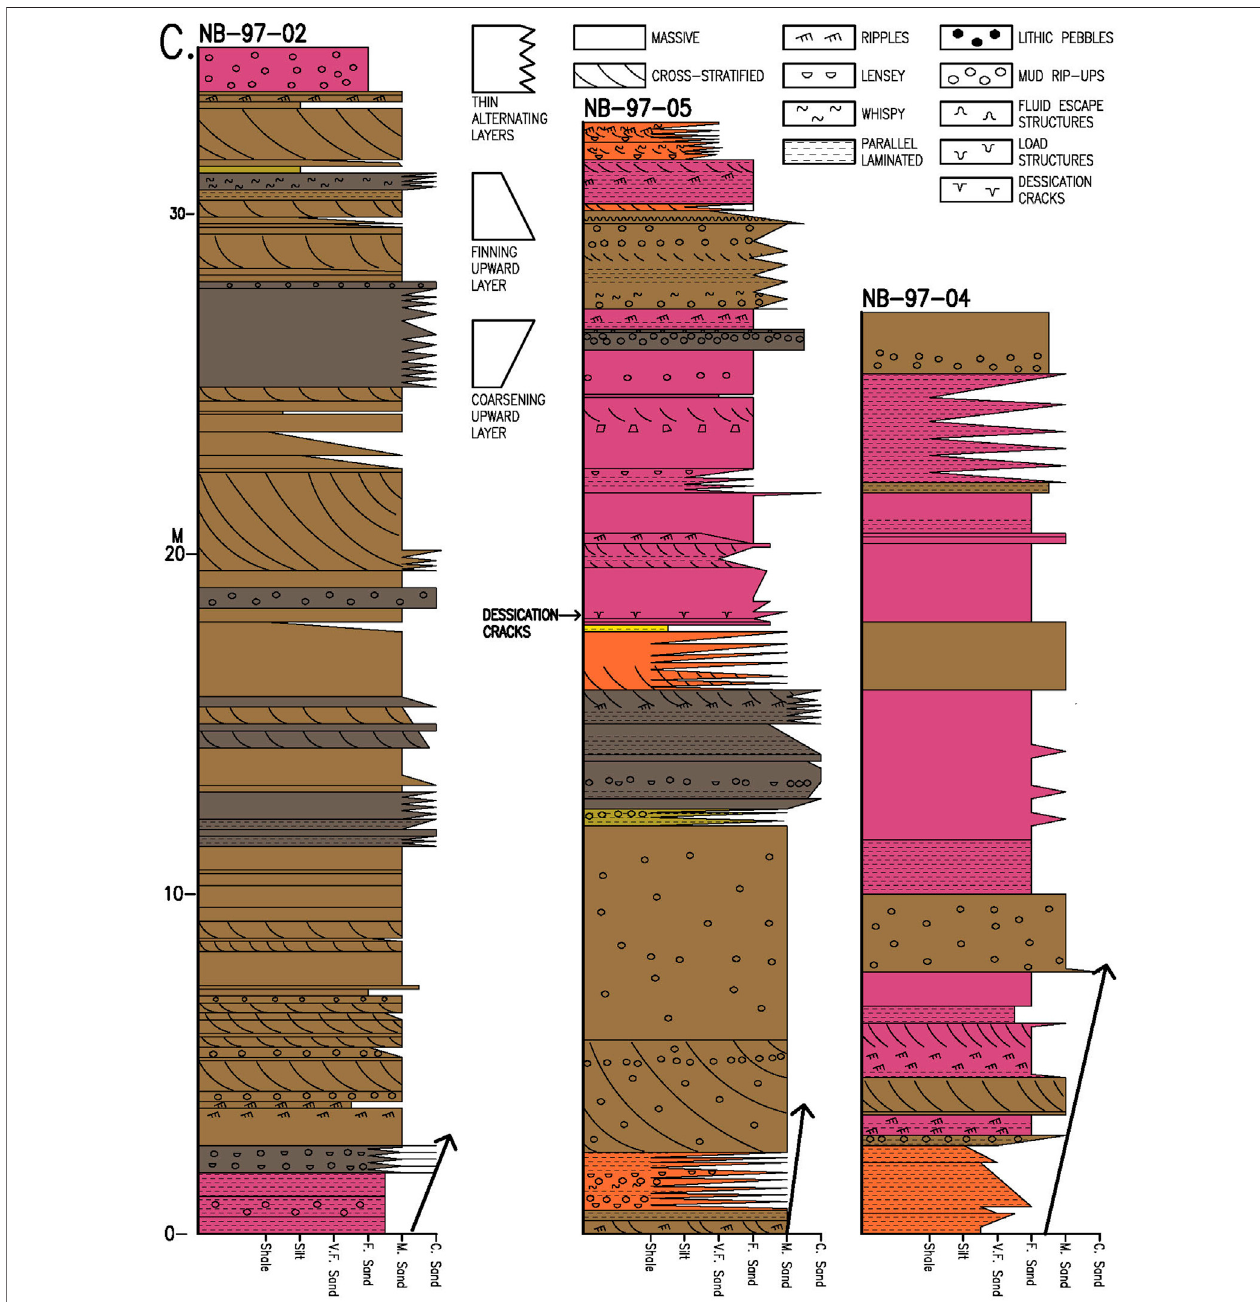
FIGURE 8 | Detail of strata present at the top of the middle coarsening-upward succession. The underlying coarsening upward parasequence is overlain by unstructureddistributary-mouthbar topsediments. Theintervalisdominated bymedium- and fi ne-grained, massiveand troughcross-strati fi edsandstones. Theoverall grainsize decreases from NB-97-05 in the northeast to NB-97-04, 4 km to the southwest. Location of detailed sections in C depicted on Figure 2 .